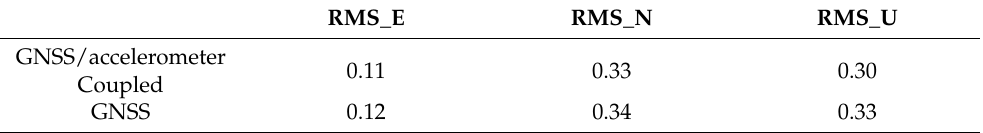
Figure 5. Coupled displacement (Dis) results of simulated landslide stability in Scene 1. Table 4. RMS statistical results when simulating the landslide stability period in Scene 1 (unit: cm).